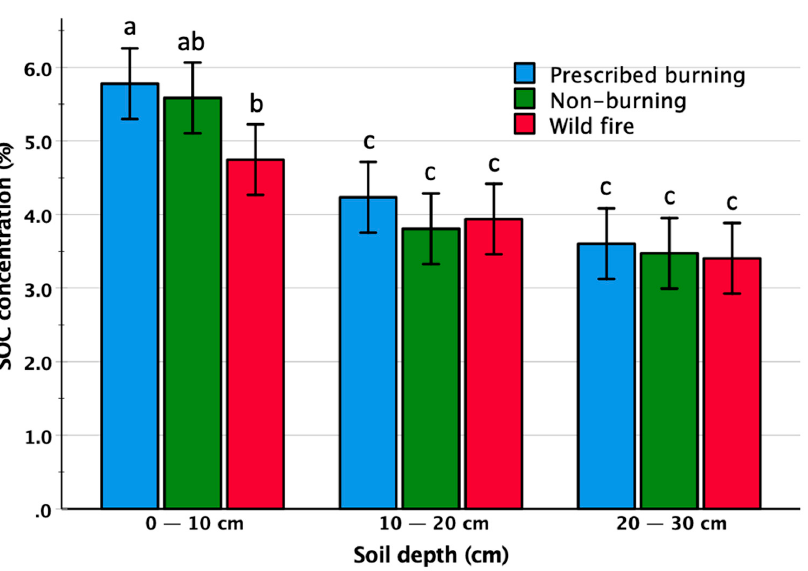
Figure 4. Soil organic carbon concentrations (%) by depth class among prescribed burning, non- burning, and wildfire sites. Different letters above the bars indicate statistically significant differences (Tukey p < 0.05) between burning treatments within the same depth class. Error bars correspond to the respective 95% confidence intervals.